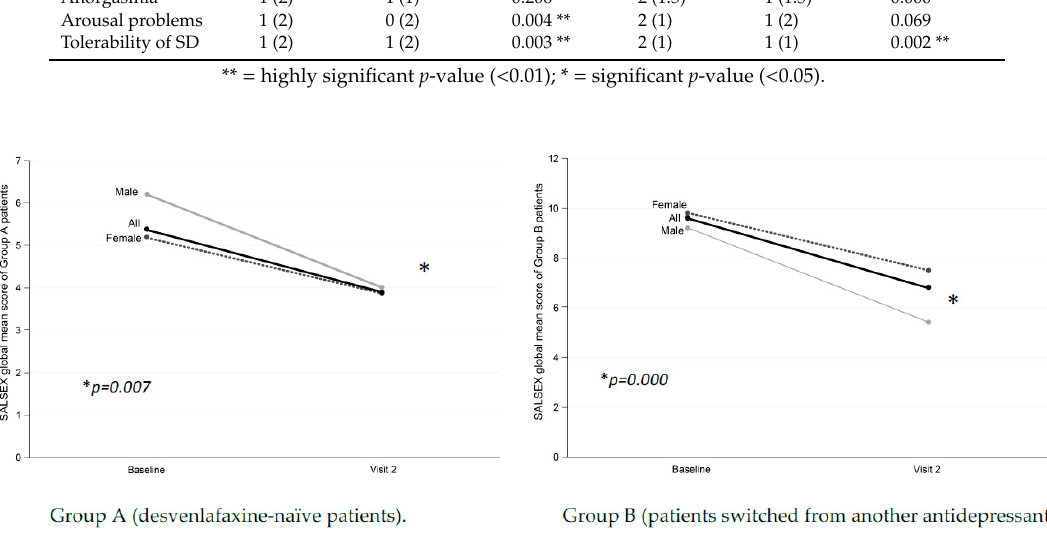
Figure 1. Differences in overall sexual function from baseline at three months in patients treated with desvenlafaxine.